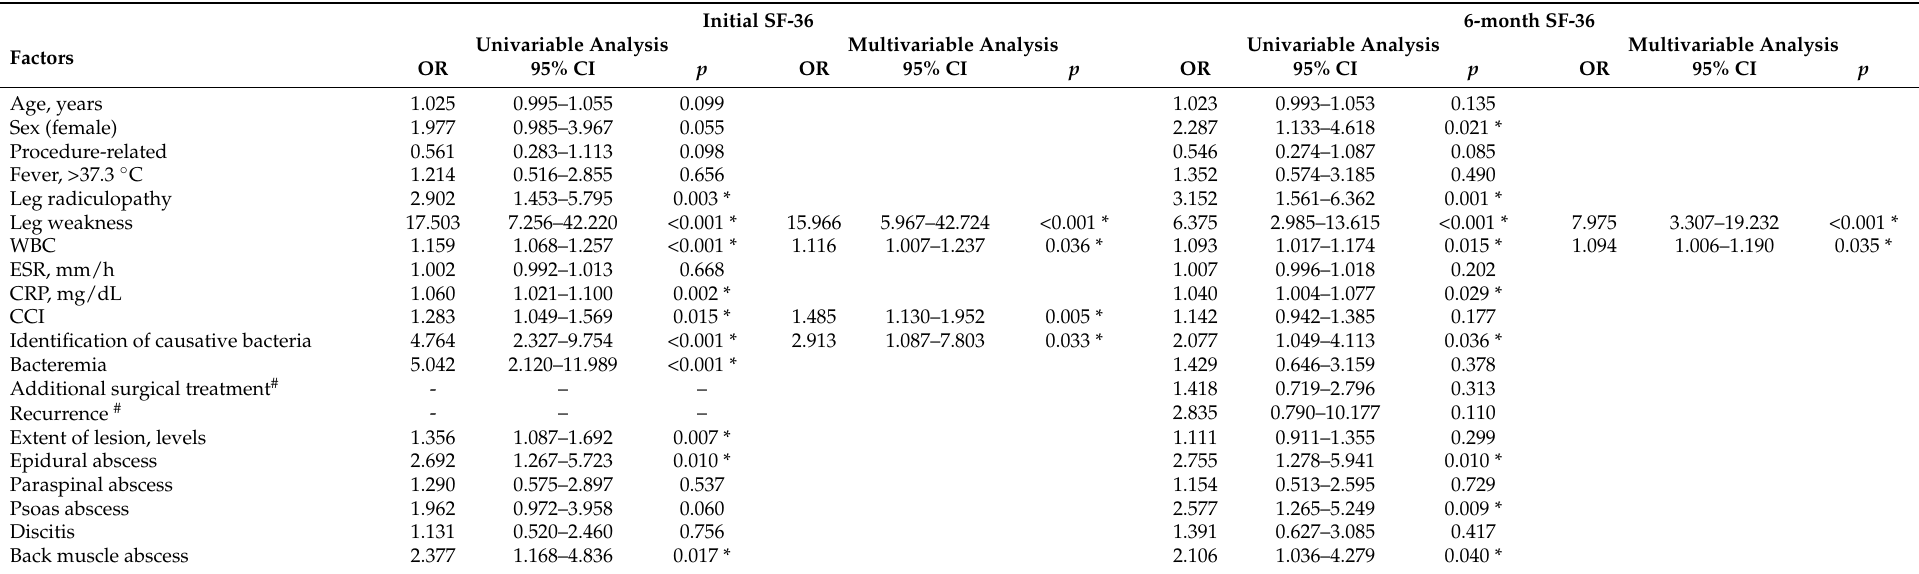
Table 6. Logistic regression analysis of clinical factors associated with below-average functional ability. SF-36, short form 36; WBC, white blood cell; ESR, erythrocyte sedimentation ratio (normal range < 20 mm/h); CRP, C-reactive protein (normal range < 0.5 mg/dL); CCI, Charlson comorbidity index; *, p < 0.05, # , only included in the analyses of 6-month